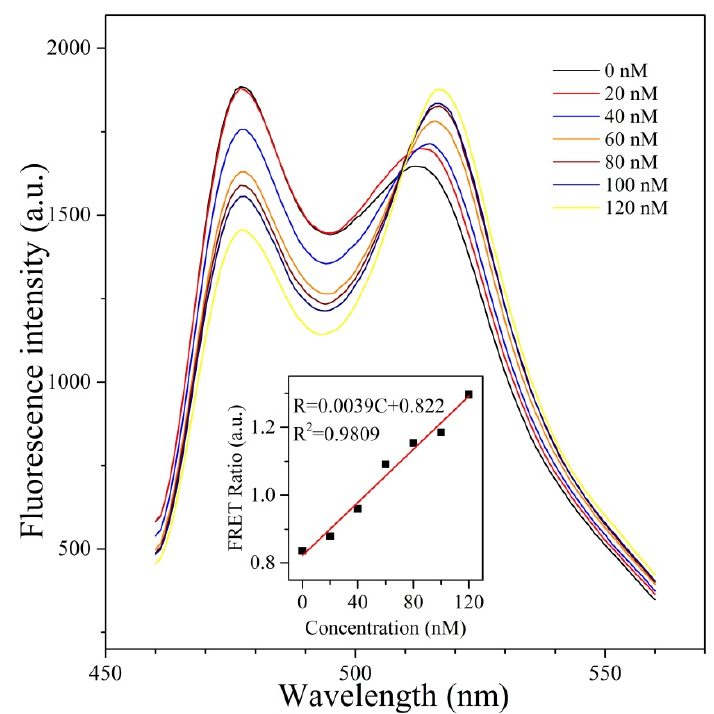
Figure 6. Detection of glucose with CPmTY. A serial of glucose solution reacted with glucose oxidase (GOX) and then the reaction products were added to 300 nM CFP-Prx and 300 nM mTrx-YFP mixtures, glucose concentrations indicated were the final ones in the detection mixtures.